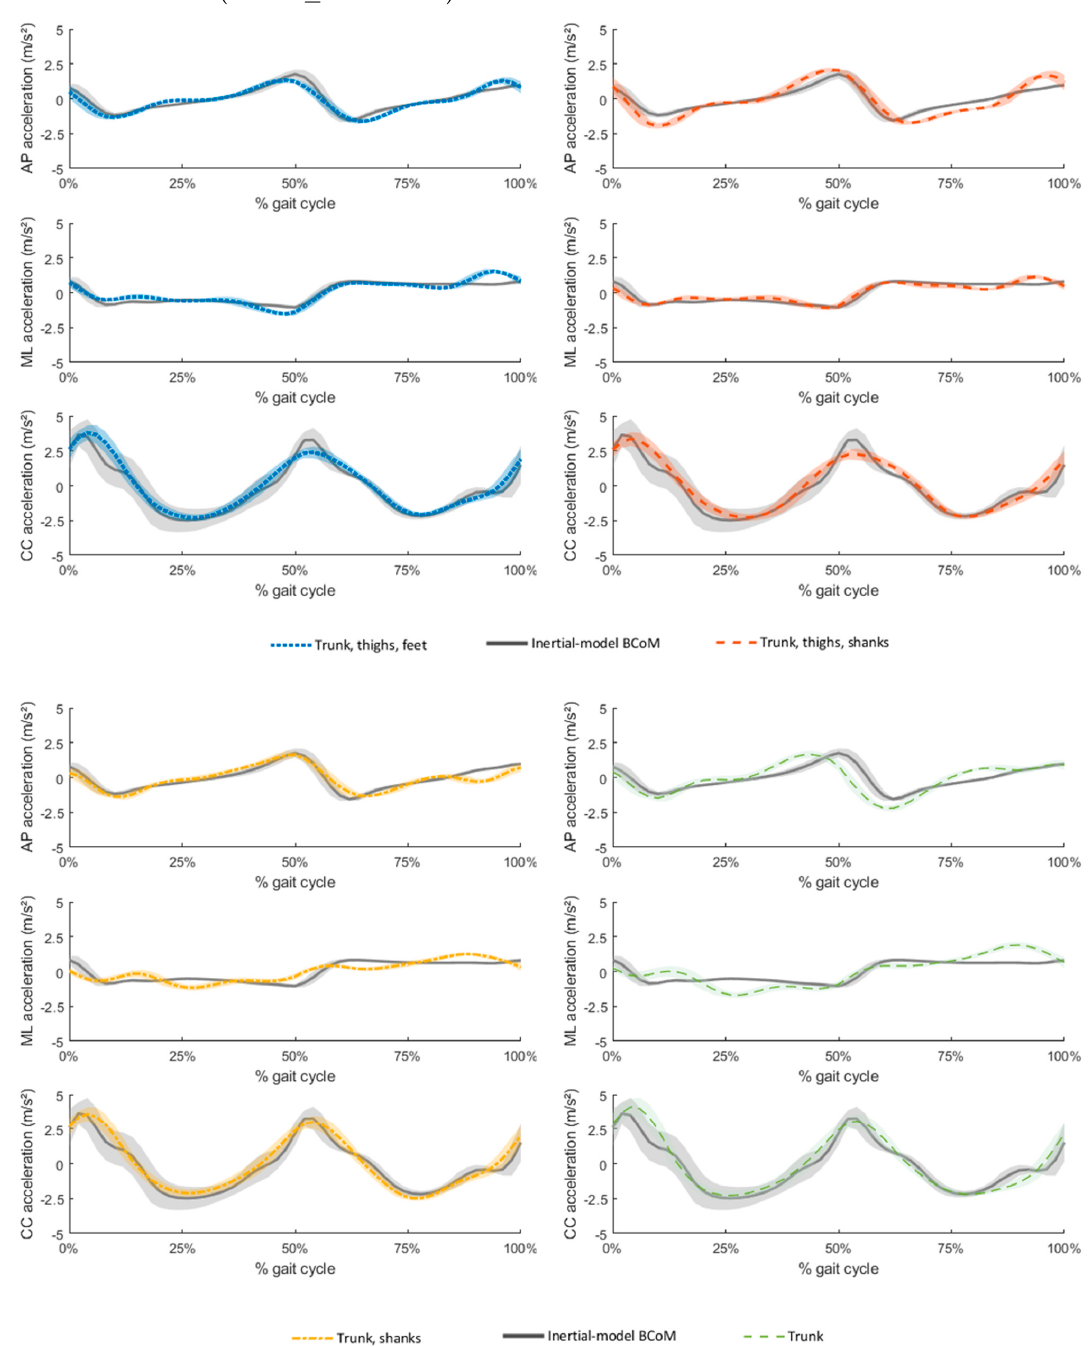
Figure 4. Acceleration of the body center of mass derived from force platform measures (gray straight line) and from the four different optimal sensor networks, consisting in the weighted sum of center of mass accelerations of the included segments (colored dashed and dotted lines), in the anteroposterior direction (AP), mediolateral direction (ML) and vertical direction (CC). Shaded regions represent the interval [mean − standard deviation; mean + standard deviation] for the estimates of the BCoM acceleration averaged over the 7 gait cycles of the participant.